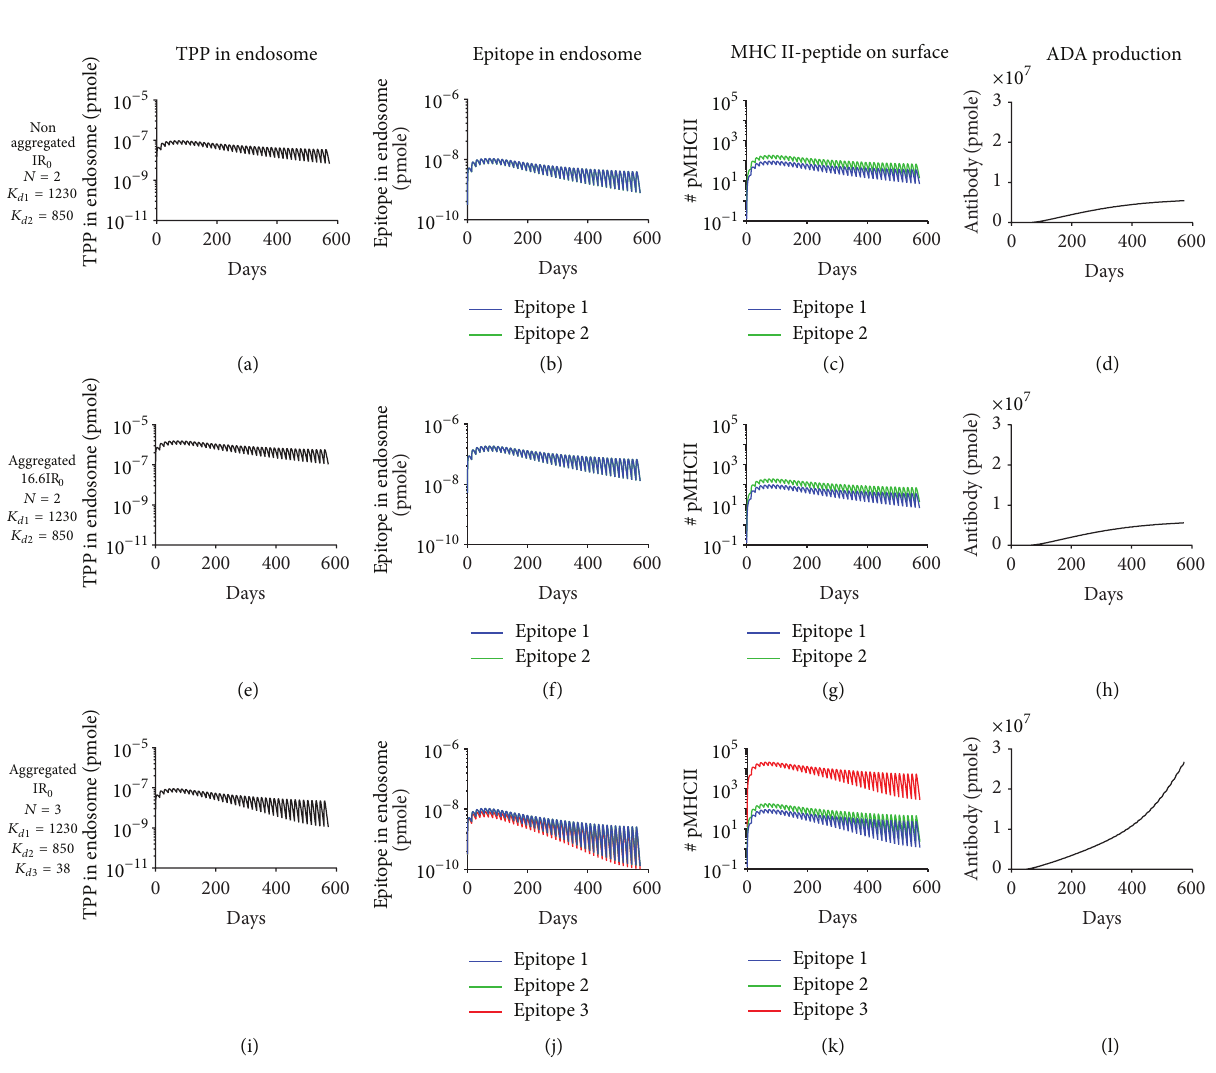
Figure 7: Aggregation could contribute to ADA production by inducing the presentation of high affinity epitopes that may not be present in nonaggregated TPP. Simulated levels of TPP in endosome, epitope in endosome, MHC II-peptide complex on cell surface, and ADA production are shown for ((a)–(d)) original internalization rate (IR 0 ) and two low affinity epitopes for hypothetical nonaggregated TPP, ((e)– (h)) 16.6IR 0 and two low affinity epitopes for hypothetical aggregated form, and ((i)–(l)) IR 0 and inclusion of a high affinity third epitope for hypothetical aggregated form. The predicted dissociation constant ( 𝐾 𝑑 , unit: nM) for binding of each epitope to MHC II is indicated. ADA production has the same definition and dose and IR 0 have the same values as in Figure